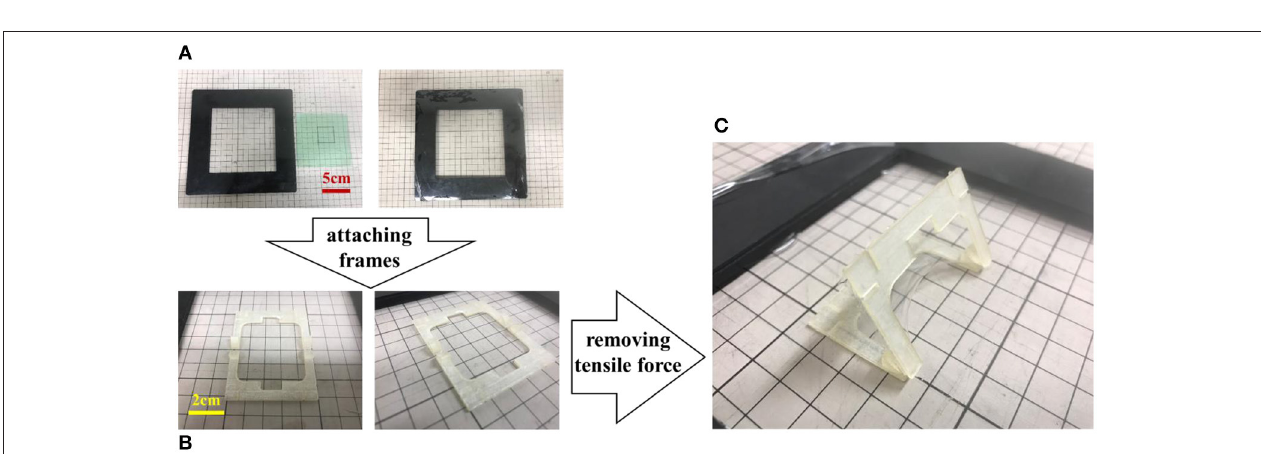
FIGURE 4 | Frame data designed in CAD software and actual printed frame. In order to realize the self-folding described in Figure 1 , the length of the short side of frame B was designed to be 0.5mm longer than that of frame A. The thickness of each frame is 0.5mm. Here, the case of θ h = 60 is shown as an example of the frame